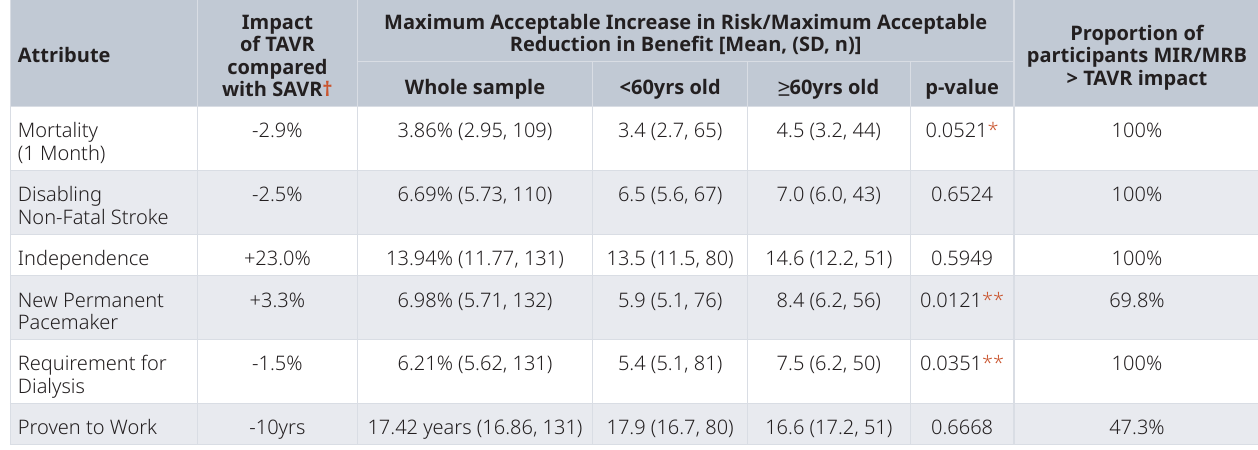
Table 5. Patients Maximum Acceptable Increase in Risk (MIR)/Minimum Acceptable Reduction in Benefit (MRB) in Exchange for Reducing Procedure Invasiveness from ‘Invasive’ to ‘Minimally